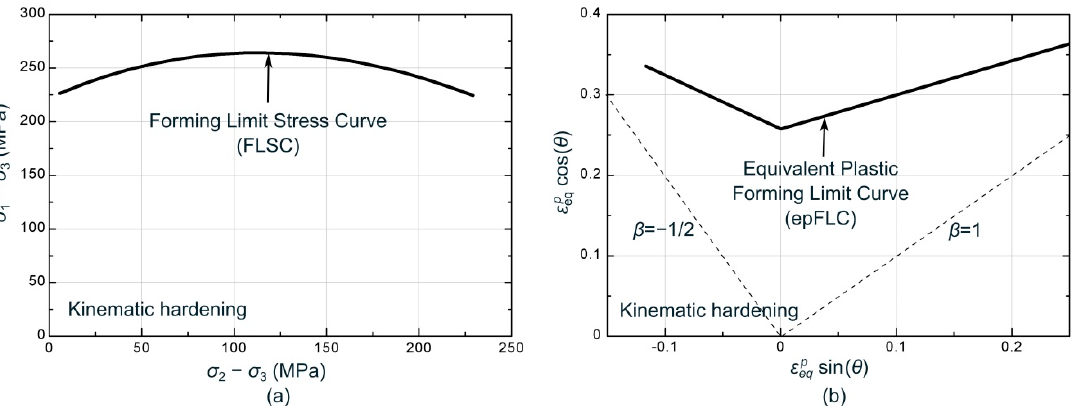
Figure 12. Numerically determined ( a ) FLSC and ( b ) epFLC based on the experimental FLC of the AA7075-O.